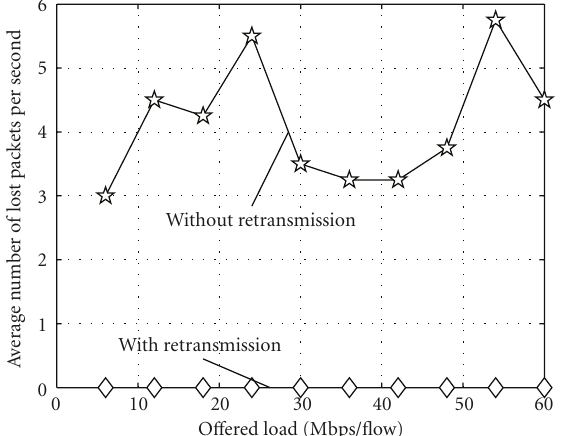
Figure 17: Number of lost packets per second at PHY observed in 4s with link adaptation.